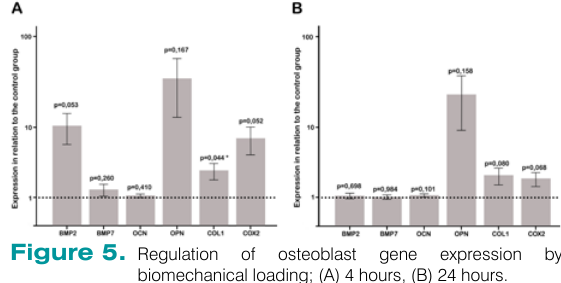
Figure 5. Regulation of osteoblast gene expression by biomechanical loading; (A) 4 hours, (B) 24